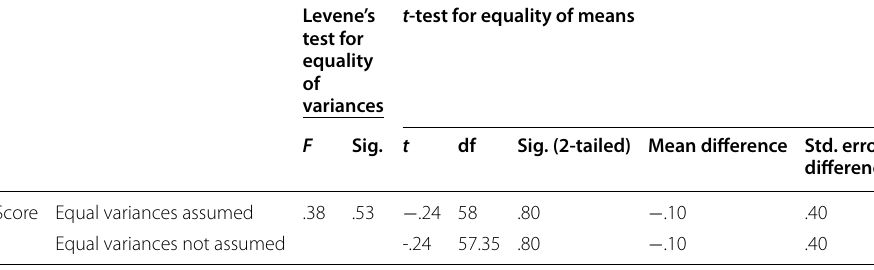
Table 2 Inferential statistics (accuracy pre‑test of both groups)